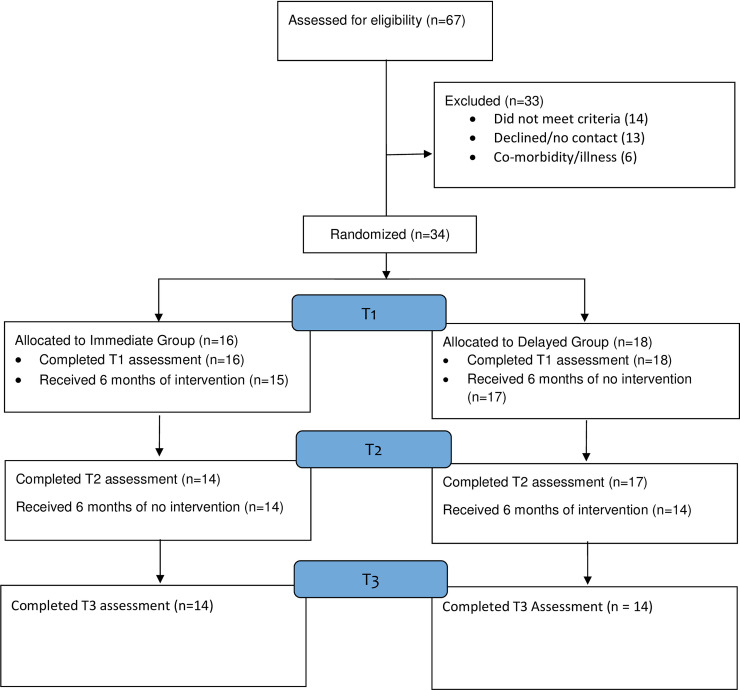
Study flow diagram.